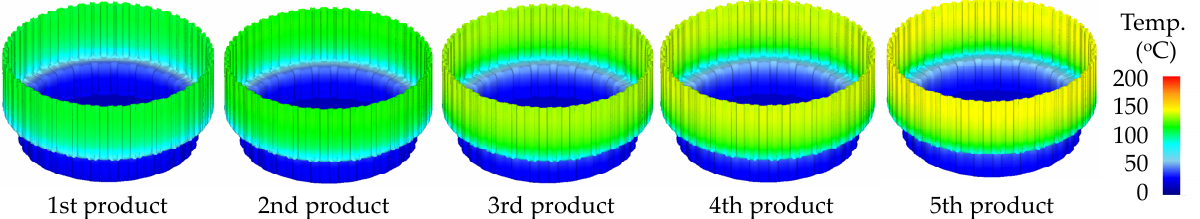
Figure 8. Temperature distributions from the 1st product to the 5th product.